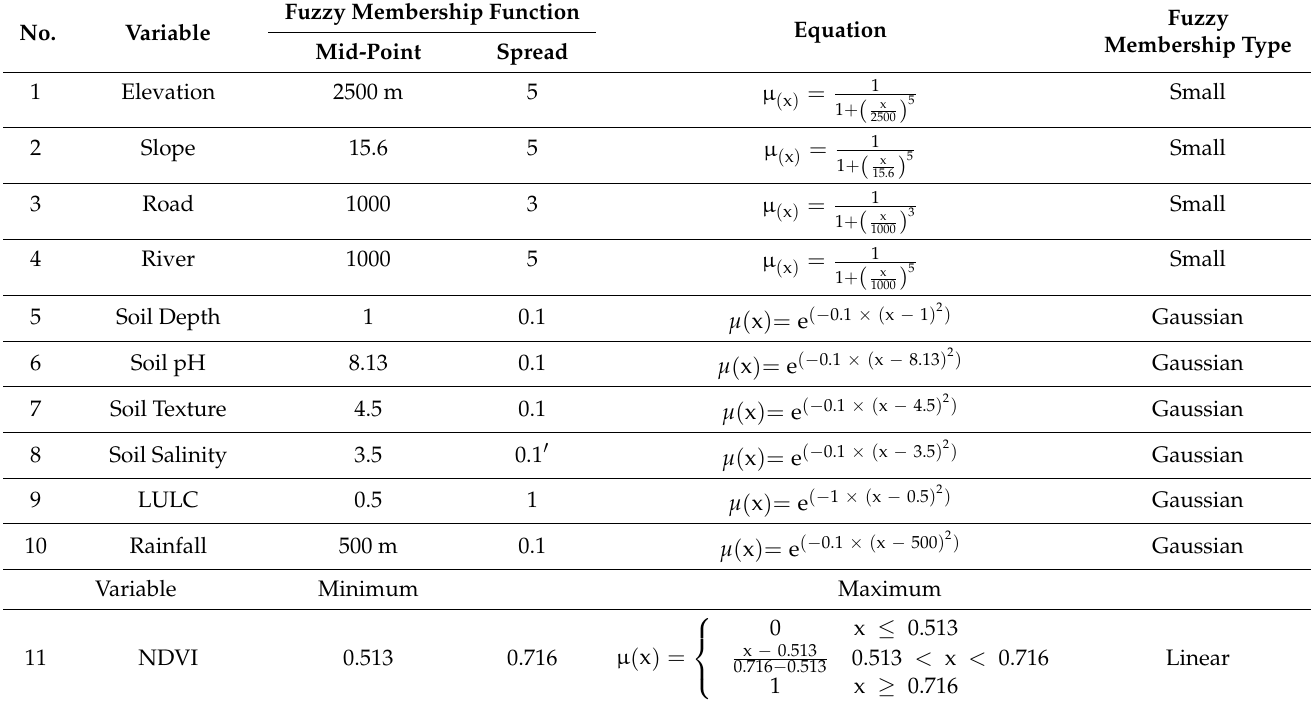
Table 2. Fuzzy Suitability membership function for